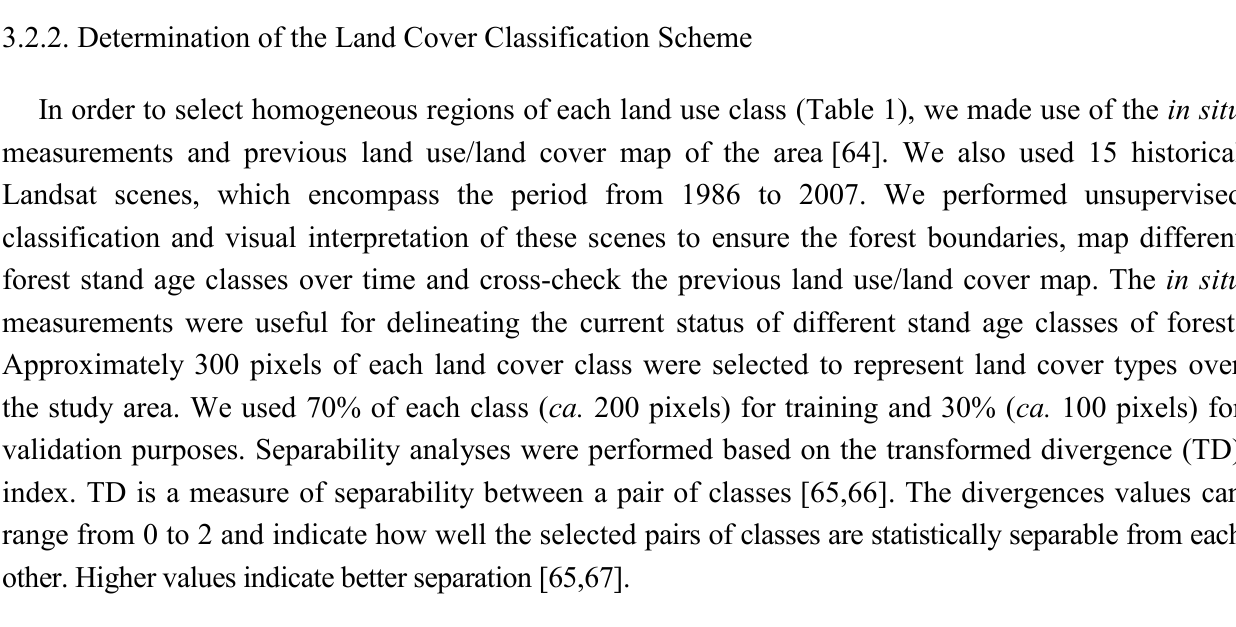
Table 5. Proposed scenarios for the classification